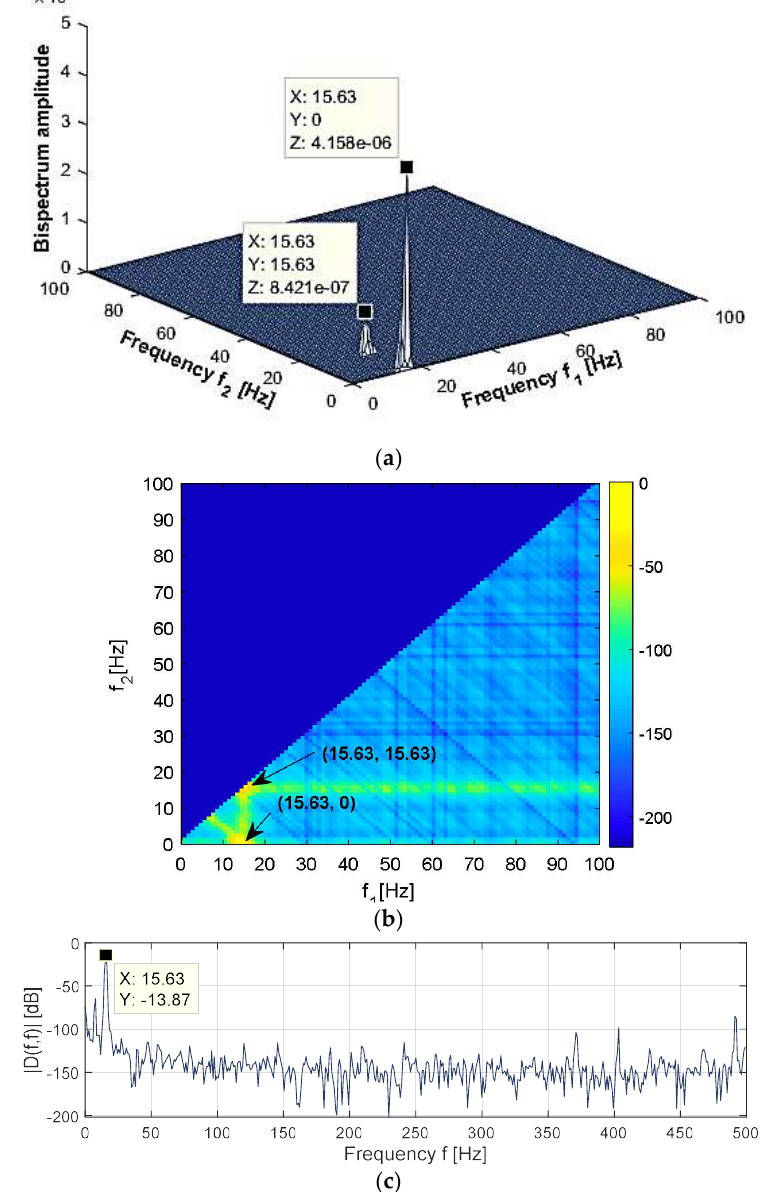
Figure 15. TST PMSG stator current with imbalanced rotor blades: ( a ) bispectrum, ( b ) normalized bispectrum amplitude, and ( c ) DSB.